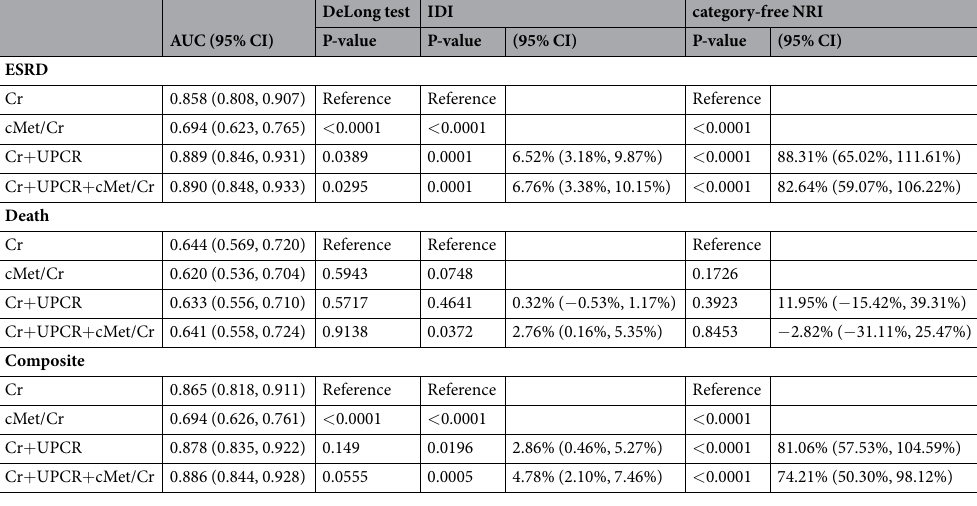
Table 3. Comparison of the ROC curve, IDI and category-free NRI of the Cr vs. Cr, UPCR vs . Cr, UPCR, cMet/ Cr in predicting ESRD. Cr, creatinine; UPCR, urine protein-to-creatinine ratio; ESRD, end stage renal disease; CI, confidence interval; IDI, integrated discriminatory improvement; NRI, net reclassification